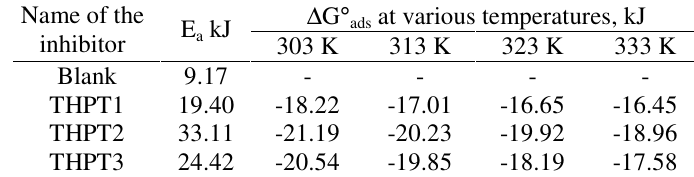
) and free energy of adsorption ( ∆ G ° a